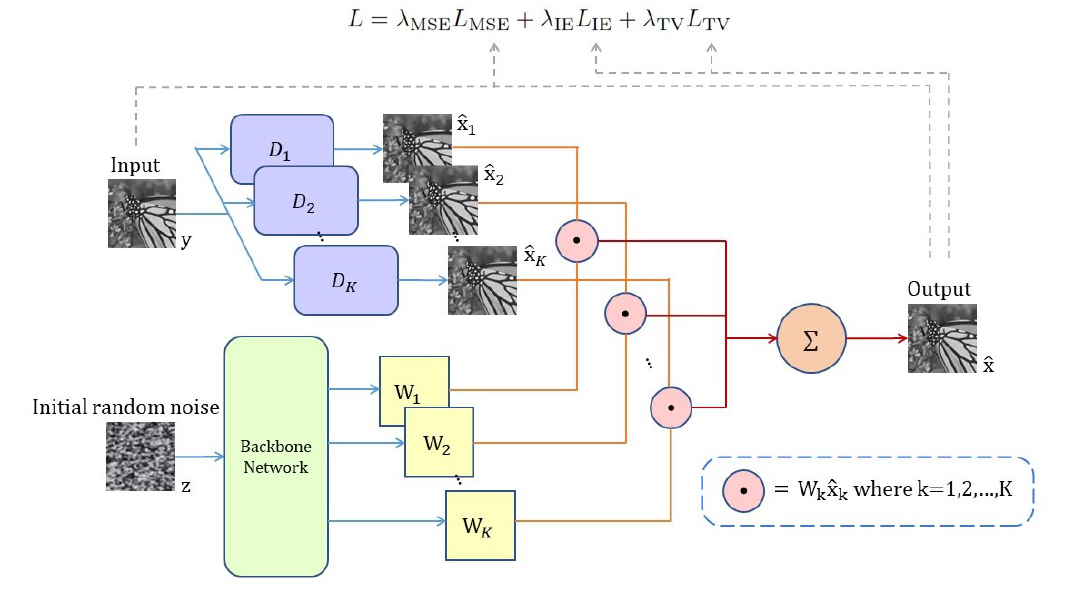
Figure 3. Pipeline of the proposed UWMGN. D 1 , D 2 ,..., D K are the image denoisers, ˆ x 1 , ˆ x 2 ,..., ˆ x K refer to the initial denoised images, W 1 , W 2 ,..., W K are the weight